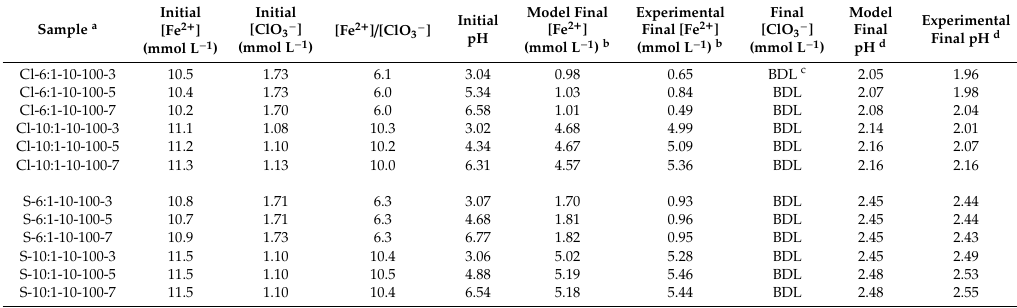
Table 1. Fluid composition of the kinetic experiments.